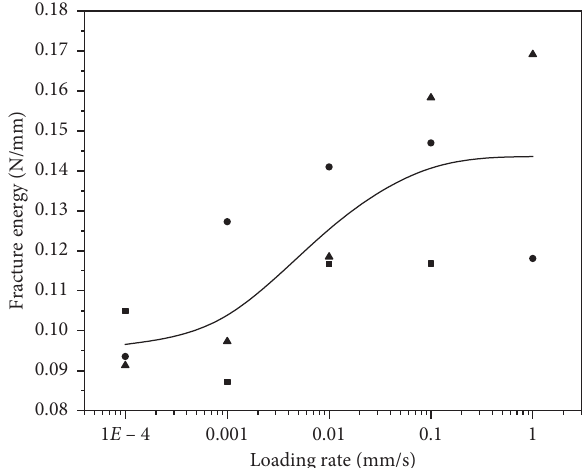
Figure 7: Effect of different loading rates on fracture